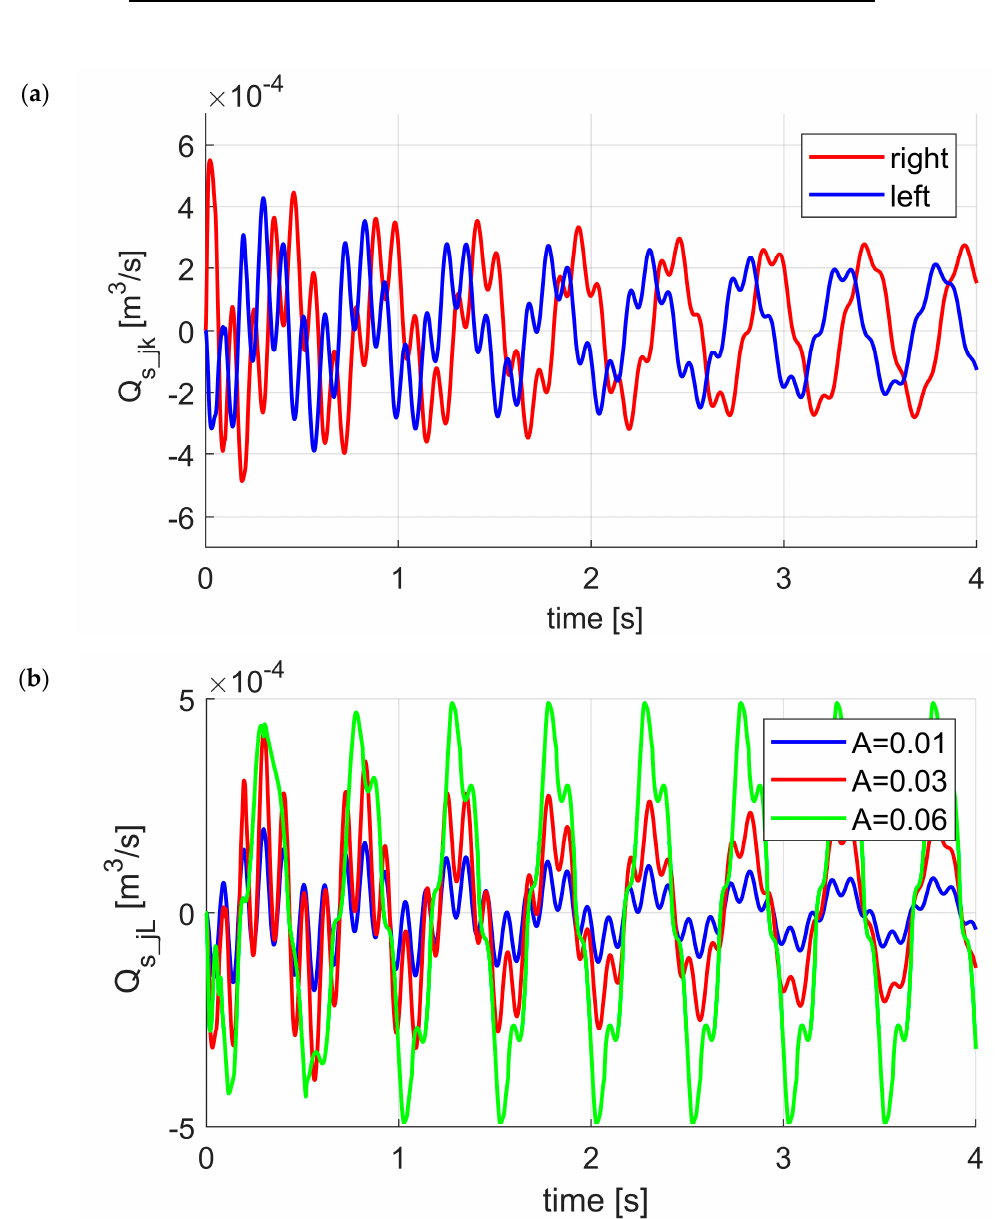
Figure 10. Comparison of the flow rates in servovalves of left and right strut actuators for excitation parameters A w _ jR = A w _ jL = 0.03 m, f w _ jR = f w _ jL = 2 Hz ( a ) and comparison of the left strut actuator parameters (cid:1827) (cid:3050)_(cid:3037)(cid:3019) = (cid:1827) (cid:3050)_(cid:3037)(cid:3013) = 0.03 m,(cid:1858) (cid:3050)_(cid:3037)(cid:3019) = (cid:1858) (cid:3050)_(cid:3037)(cid:3013) = 2 Hz ( a ) and comparison of the left strut actuator flow rates in servovalve for di ff erent excitation amplitudes ( b flow rates in servovalve for different excitation amplitudes ( b ).